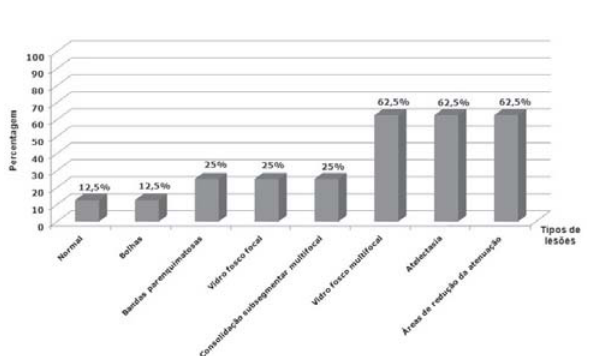
Fig. 2 - Porcentagem dos achados tomográficos nos pacientes tratados cirurgicamente para oclusão do canal arterial (grupo B)